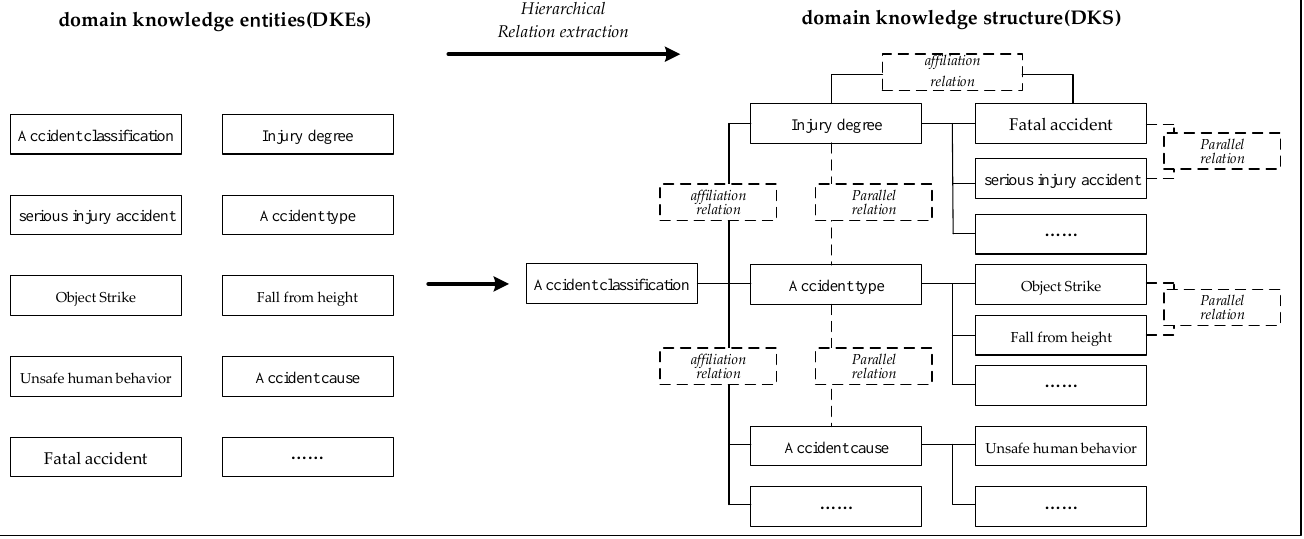
Figure 1. A simple example of domain DKEs and their hierarchical relations.